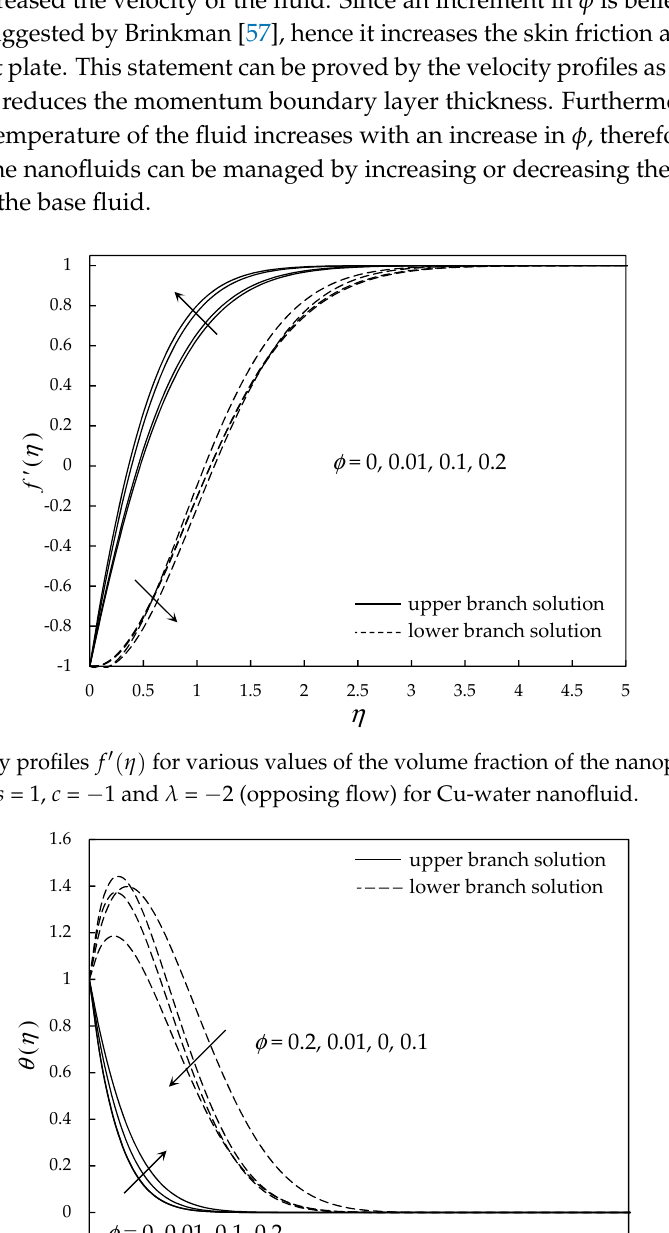
Figure 15. Variation of the reduced local Nusselt number −𝜃′(0) with the mixed convection parameter 𝜆 when 𝜙 = 0.01, Nr = 0.1, K = 0.1, s = 1 and c = − 1 for Cu-water, Al 2 O 3 -water and TiO 2 - water nanofluids.